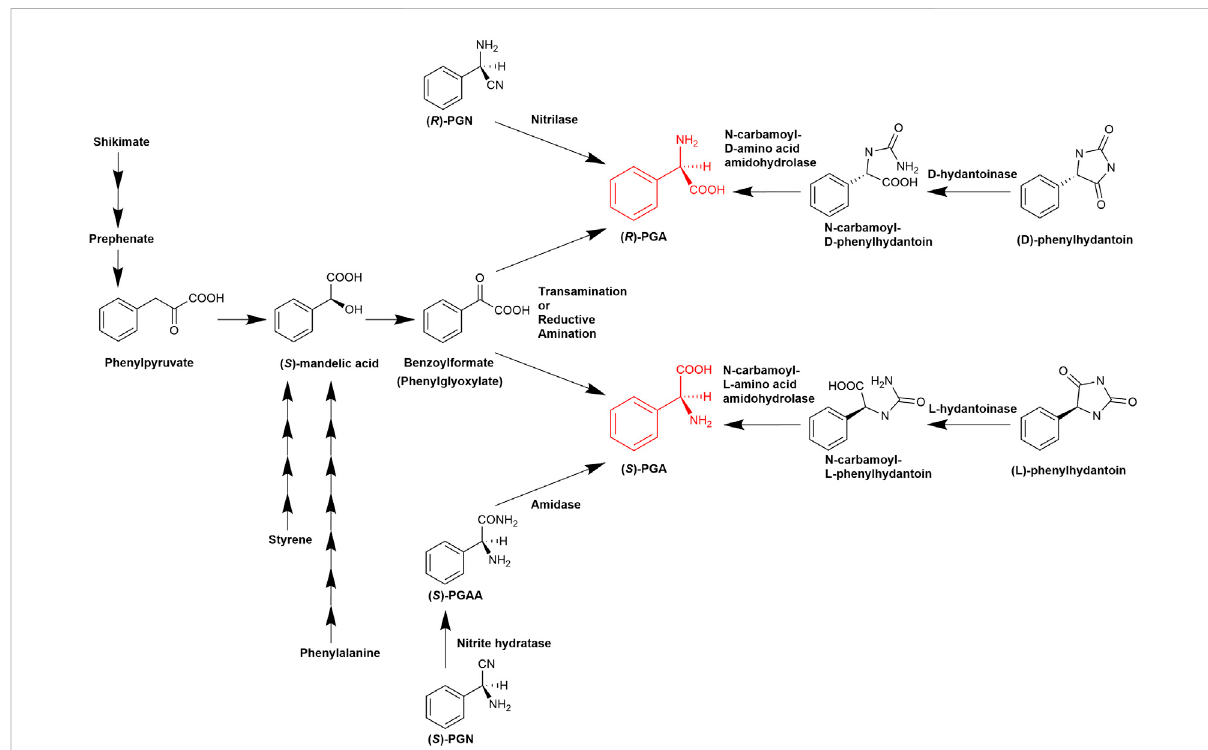
FIGURE 1 Established pathways for the enzymatic synthesis of ( R )- or ( S )-phenylglycine (Olivieri et al., 1979; Williams and Hendrix, 1992; Gokhale et al., 1996; Hensel et al., 2002; Mei et al., 2008; Al-Toma et al., 2015; Zhou et al., 2017. Liu et al., 2016; Eppinger and Stolz, 2019; Moosmann et al., 2020; Tang et al.,